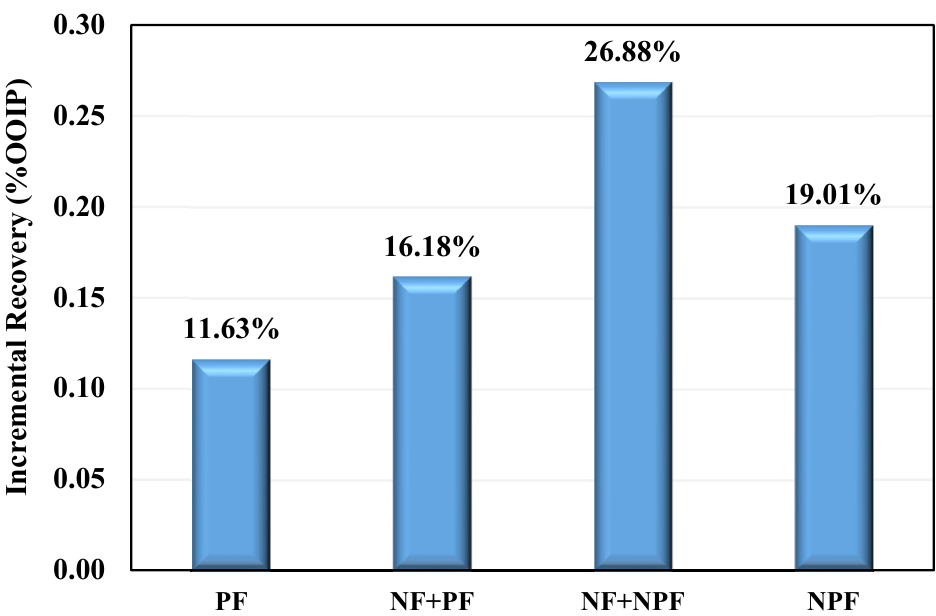
Figure 11. Comparison of incremental oil recovery for each scenario.